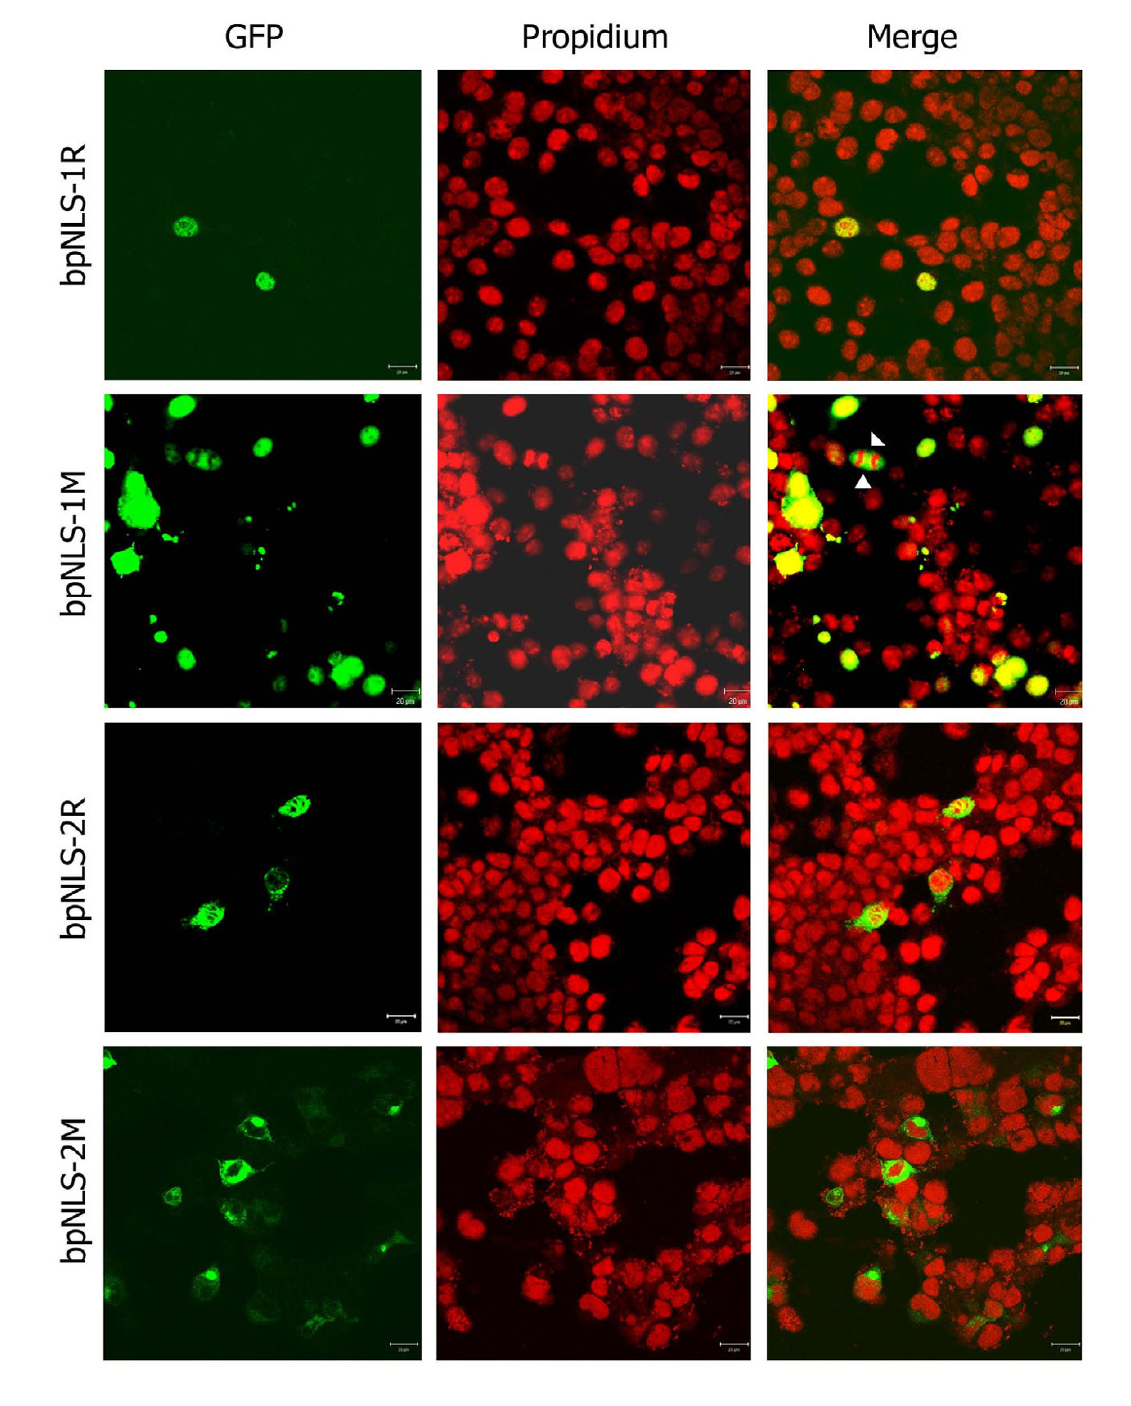
Figure 6 Expression analysis of bpNLS-1 and bpNLS-2. bpNLS-1R and bpNLS-2R (with R 105 ) localizes predominantly to the nucleus. Note that the bpNLS-1M (with M 105 ) exhibits a predominantly cytoplasmic localization pattern but also localizes to the nucleus as well. Arrows indicate a dividing cell with two daughter nuclei and the bpNLS-1M demonstrating an exclusive cyto- plasmic localization. bpNLS-2M (with M 105 ) localizes to the